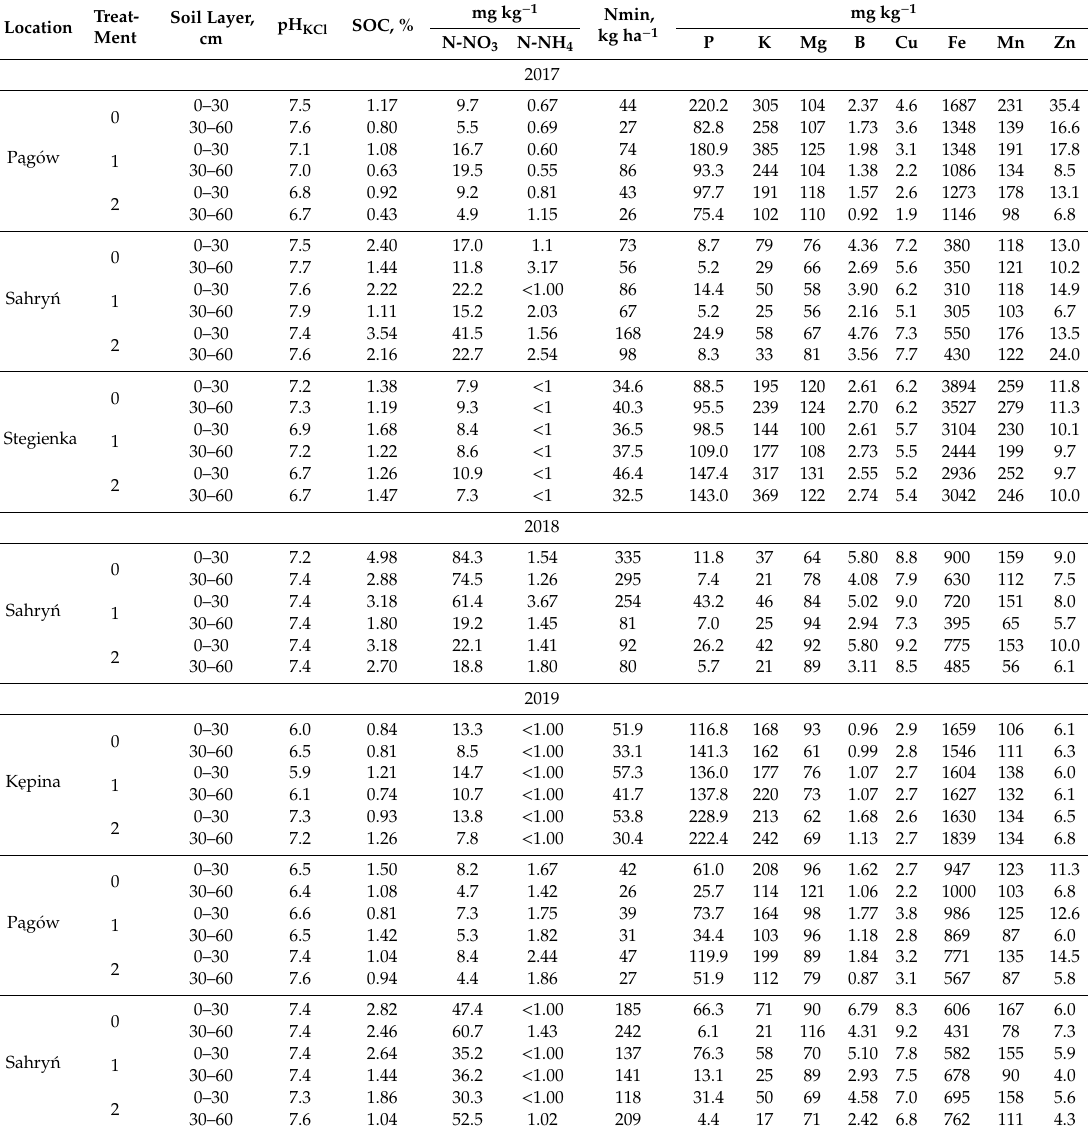
Table 4. Soil conditions after the harvest of sugar beet